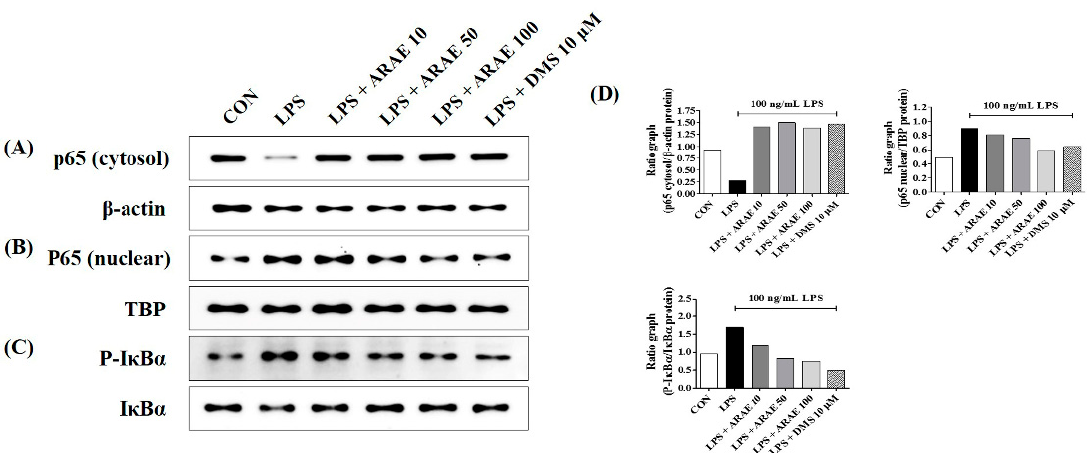
Figure 3. Effects of ARAE on nuclear factor (NF)- κ B p65 ( A ) cytosol, ( B ) nuclear protein expression, and ( C ) phosphorylation and degradation of inhibitor of NF- κ B alpha (I κ B α ). Cells were seeded on a culture plate and pre-incubated for 18 h. Control cells were incubated with vehicle alone. Cells were stimulated with LPS for ( A , B ) 1 h or ( C ) 30 min. ( D ) The histograms show protein expression levels relative to those of the internal control. CON: control; LPS: lipopolysaccharide; ARAE: Atractylodis Rhizoma Alba ethanolic extract; DMS: dexamethasone.